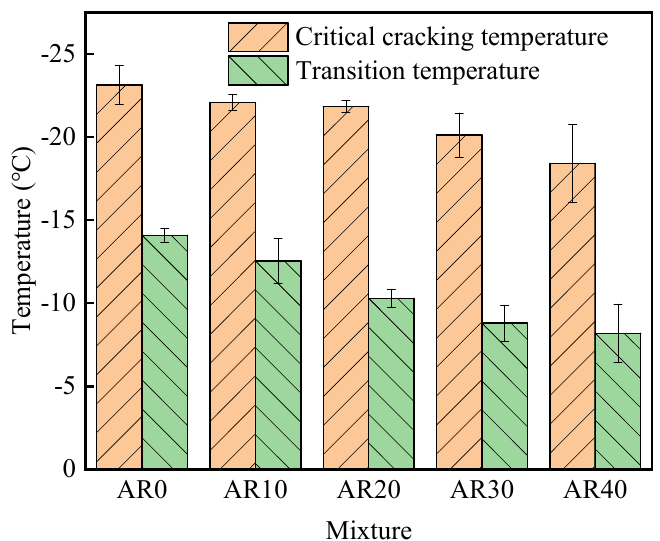
Figure 6. CCT and transition temperatures of various mixtures.